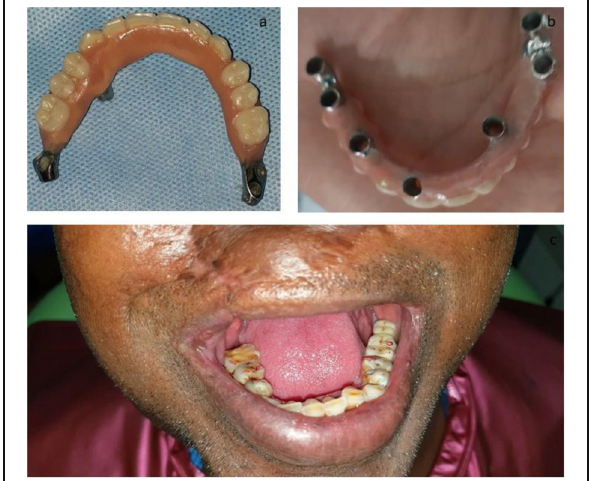
Fig. 7 a - c The metal to acrylic hybrid prosthesis. The anteriors were set up in a crossbite and the posterior teeth accordingly to the concept of strategic occlusion